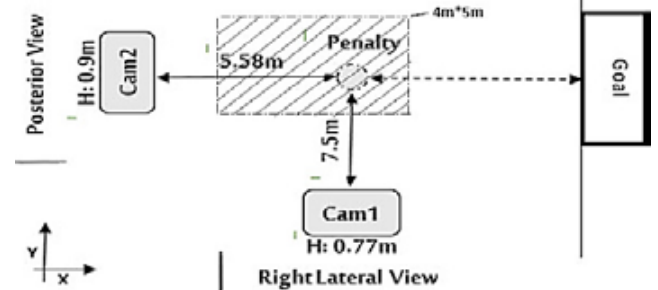
Figure 1. The method chosen to calculate the variables analysed in